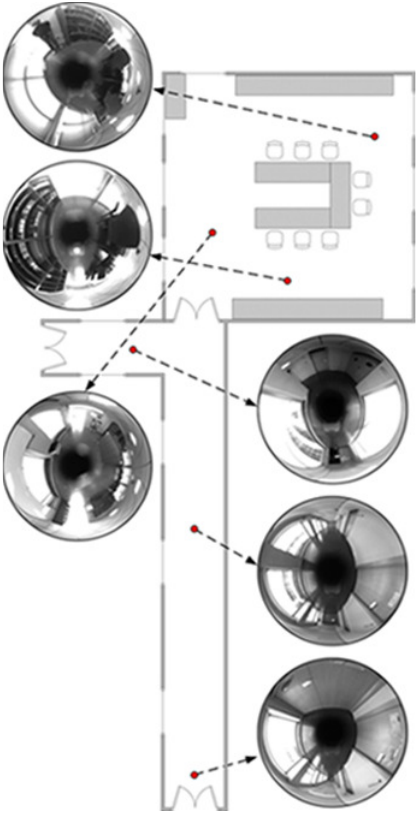
Figure 12. Mockup for Dataset 1. Six views of the environment are indicated.